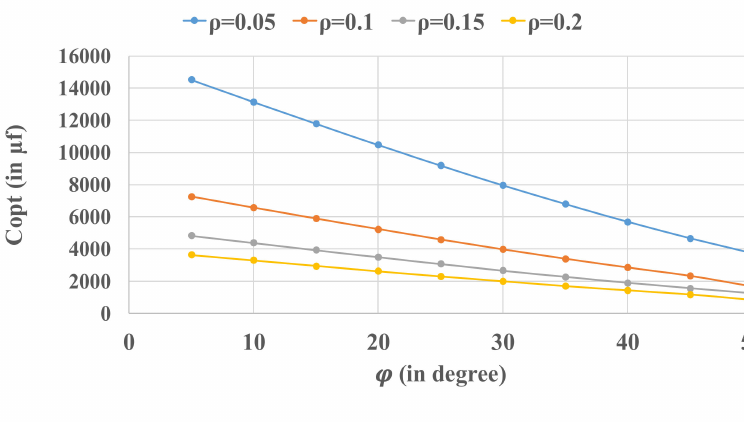
Figure 8. Variation of capacitance with phase angle for di ff erent Values of ripple Voltage of capacitor C 3